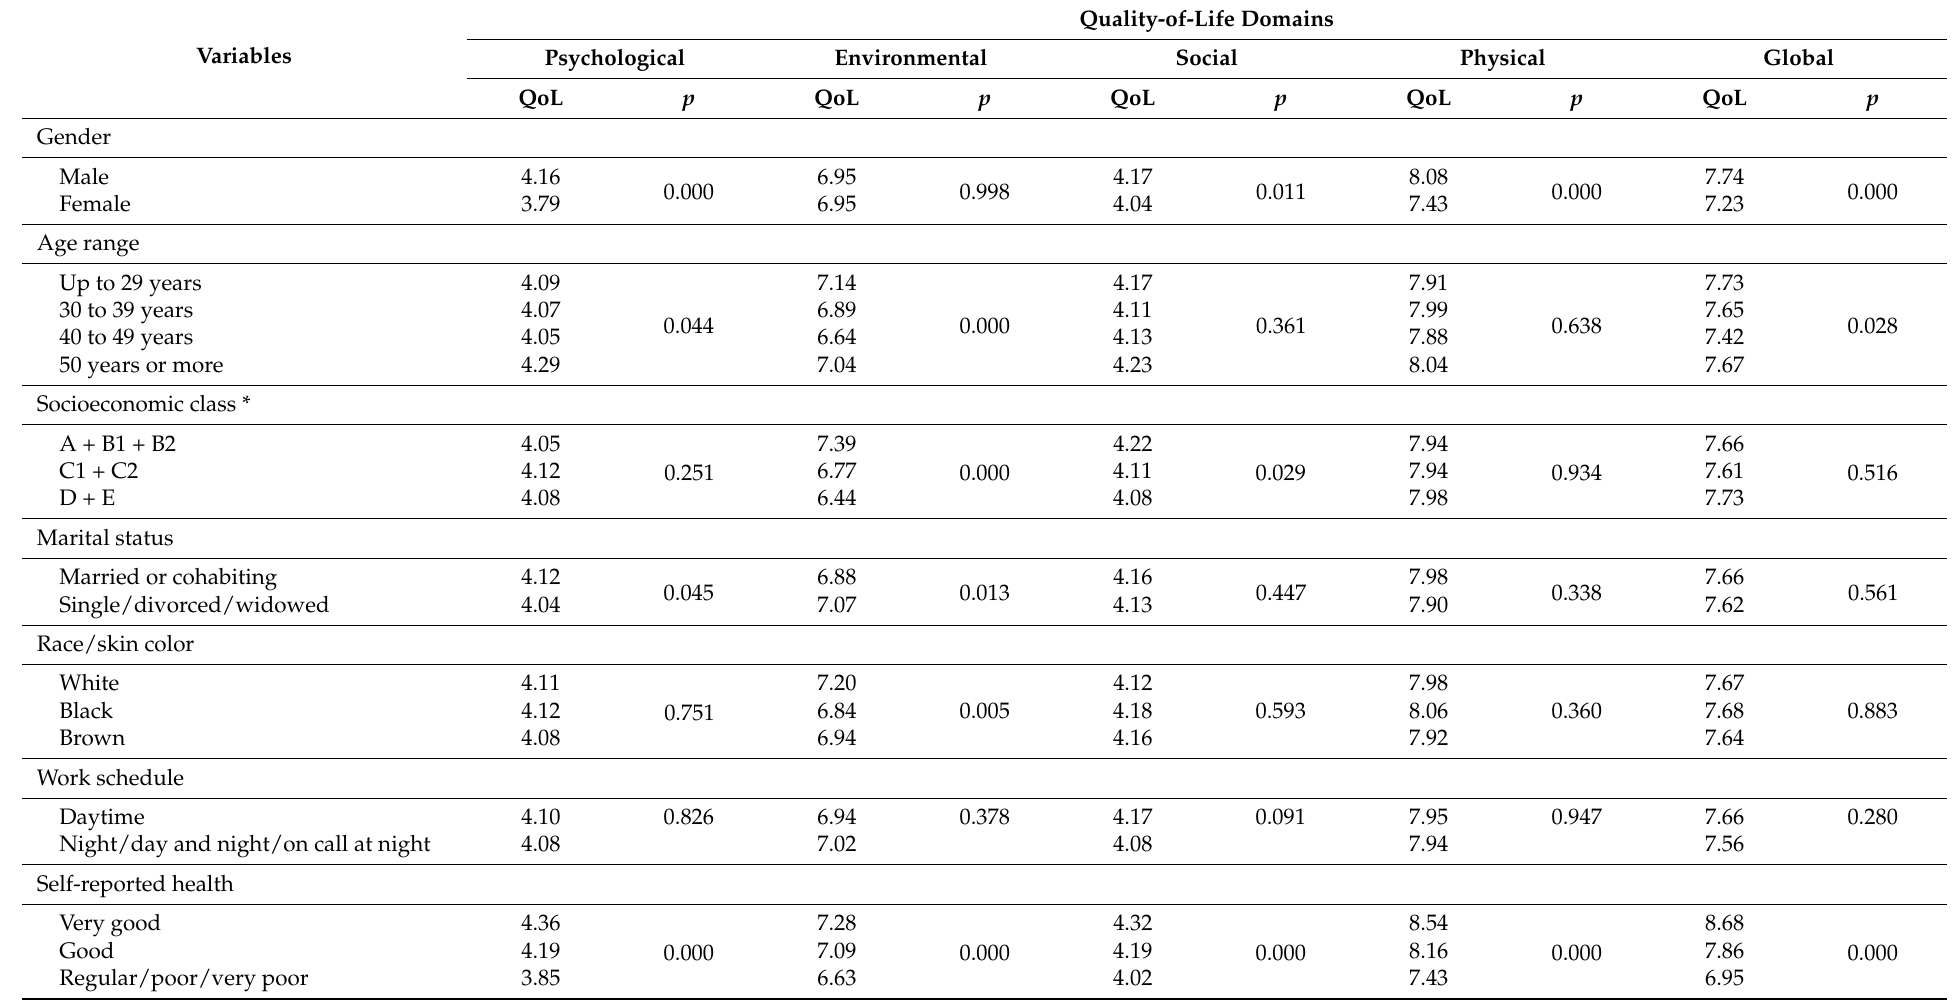
Table 2. Influence of each sociodemographic, economic, and behavioral characteristic on quality-of-life domains.